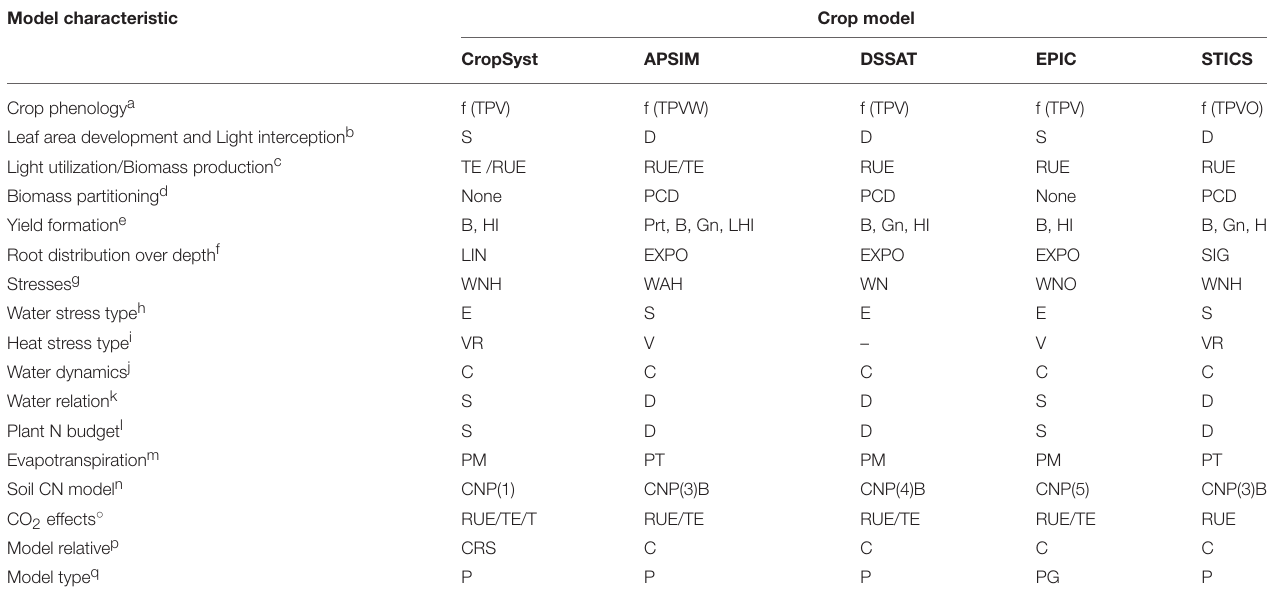
Model characteristic Crop